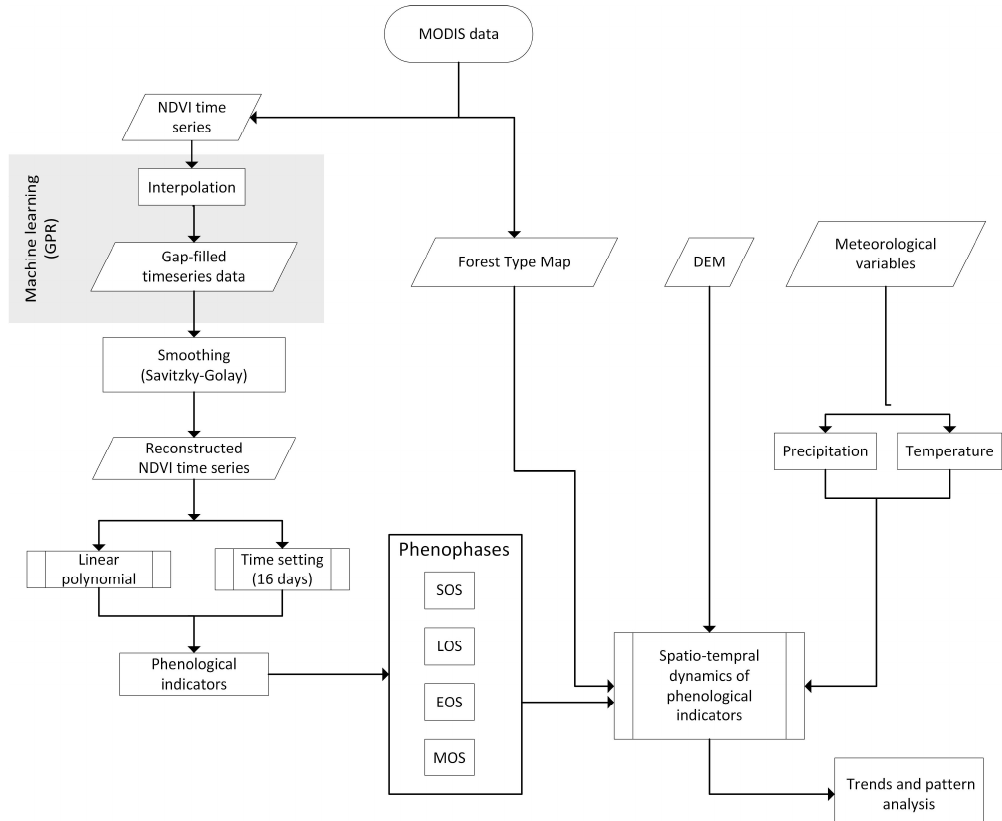
Figure 2. Flowchart of functions used in the present study.